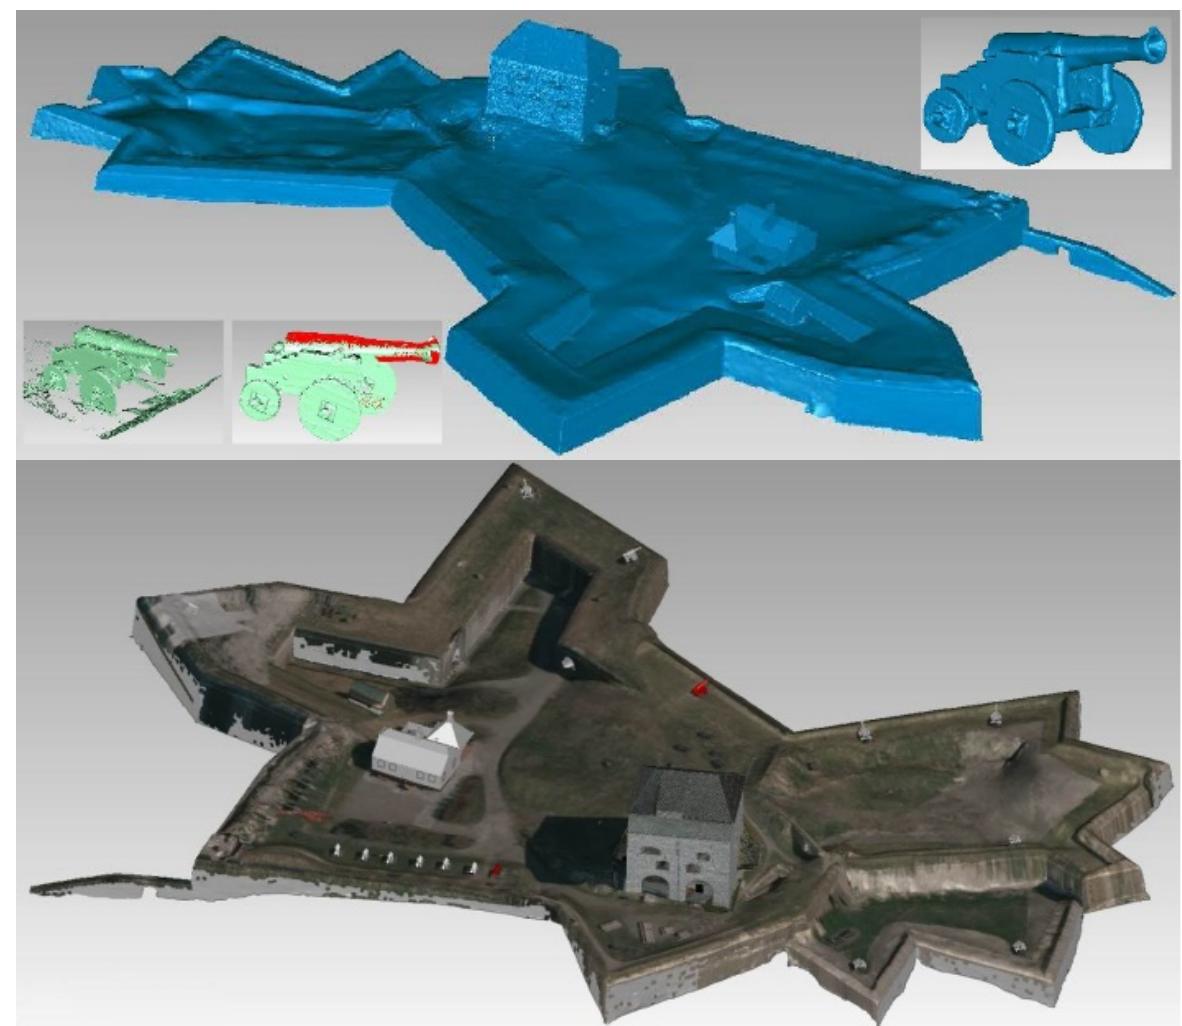
Figure 4: Fortification Kristiansten as meshed 3D model including modelled canons (top) and 3D model textured in Geomagic